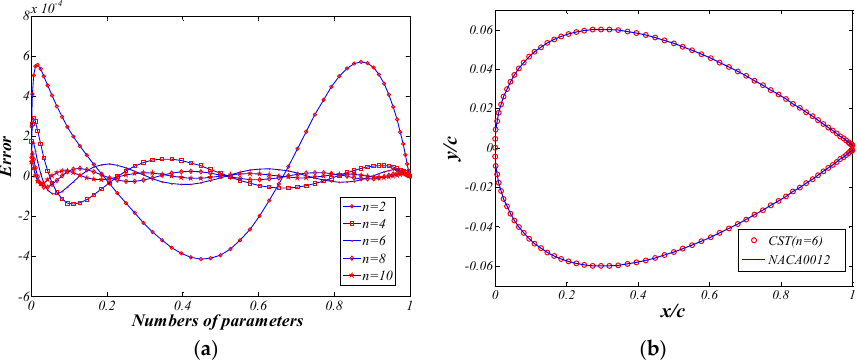
Figure A1. Geometric representation and error analysis. ( a ). The error with the number of parameters; ( b ). Airfoil parameterized by six design variables.